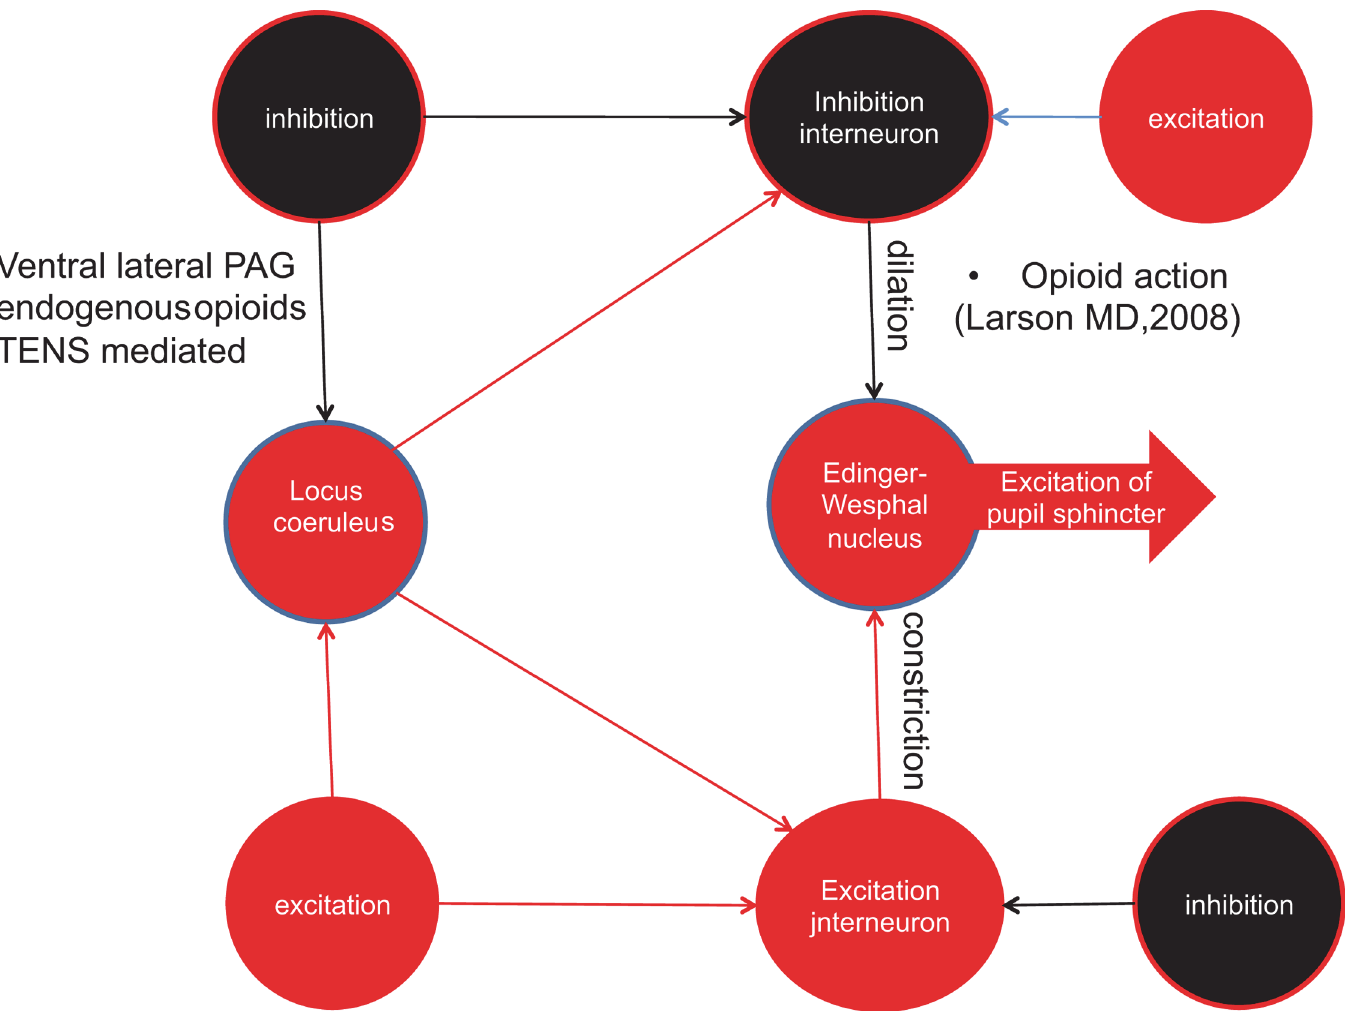
Fig 3. Mechanism of Endogenous Opioid Action Induced by LF TENS in Non-Anesthetized Subjects with Pupil Miosis. The locus coeruleus- noradrenergic system (LC) has been suggested to be a key structure in arousal, and its firing frequency tone has been correlated with wakefulness, vigilance, and sensory and pain perception. The size of the pupil correlates with the activity of LC, and light increases the frequency of firing. The action of the LC excites the excitation pathway that directly induces pupil constriction and excites inhibitory interneurons in the inhibitory pathway, exciting the inhibitor of the inhibitor; the net result is a reduction of inhibition and, indirectly, an agonist effect of the excitatory pathway of pupil constriction. Opioids act on the inhibitory pathway, and TENS has been suggested to be activated via the ventral lateral PAG and the opioid pathway. According to Valentino [74] and Curtis [75], opioids reduce the activation of the LC, and corticotropin-releasing hormone (CRH) increases the firing rate. It is possible that low-frequency sensory TENS inhibits LC inhibitory interneurons, increasing the tone of the pupillary constrictor of the LC. TMD patients could suffer from an impairment of the inhibitory pathway stemming from the ventral lateral PAG. Consequently, pupil constriction in response to light is not counterbalanced by inhibition (smaller pupil size under yellow-green light), and low-frequency sensory TENS is unable to further induce pupil constriction. Red, excitation pathway; black, inhibitory